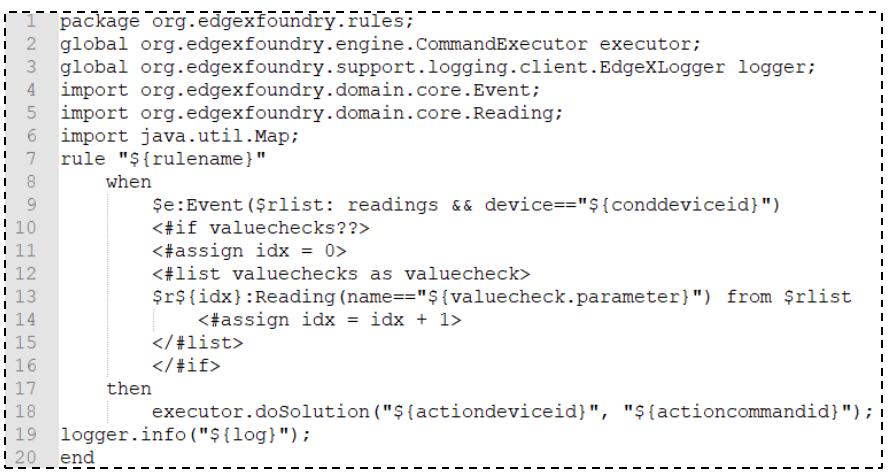
Figure 11. Drools template in the rules engine for creating a Drools profile.